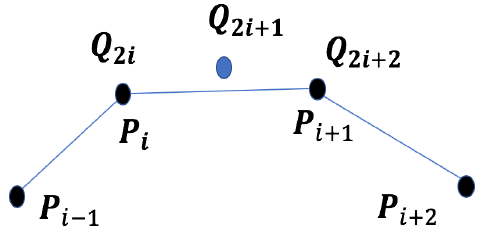
Figure 9. Four-point subdivision scheme